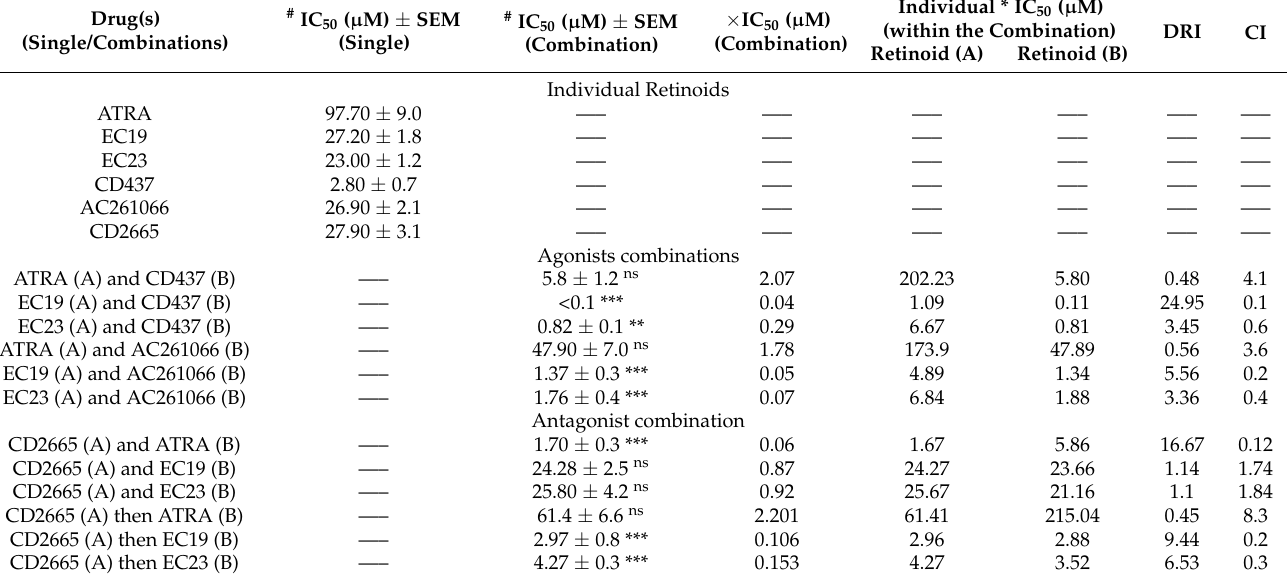
Table 1. The in vitro antiproliferative activity and Isobologram analysis of the individual retinoids and combinations with CD437, AC261066 and CD2665 (using fixed ratios of the individual IC 50 values) in Caco-2 cells. Dose reduction index (DRI) and combination index (CI) was calculated. Data represent mean ± SEM, n =